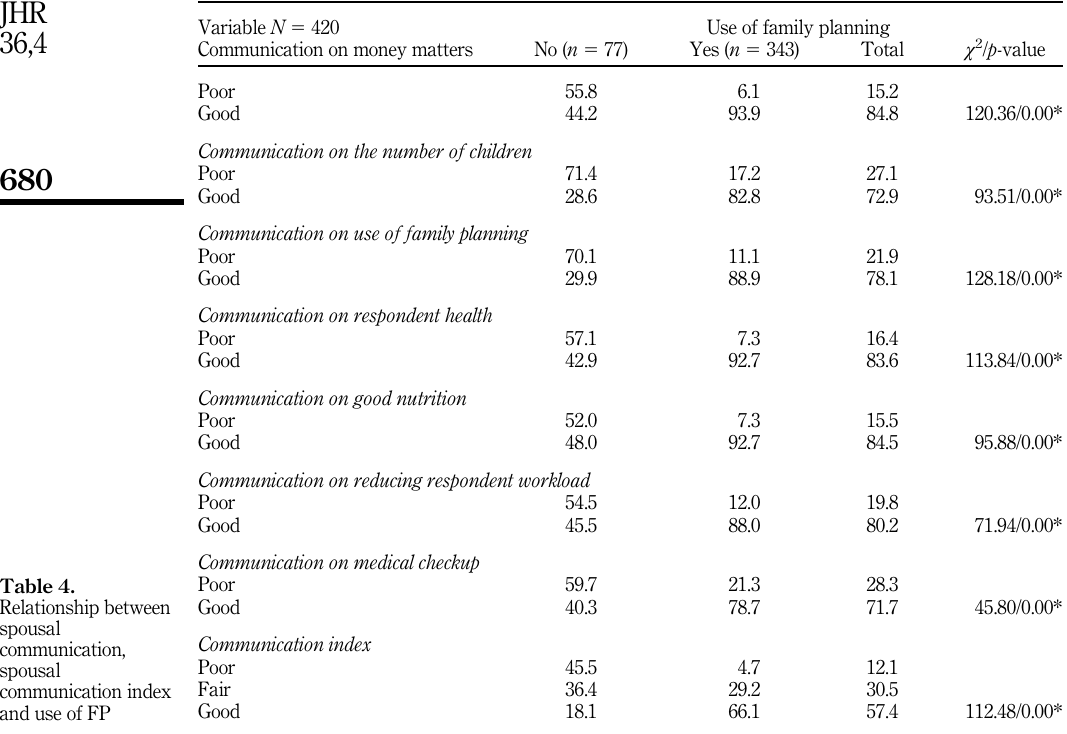
Table 4. Relationship between spousal communication, spousal communication index and use of